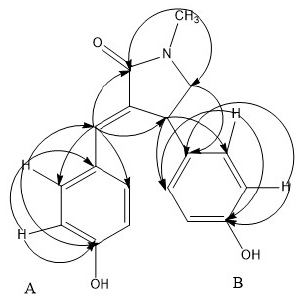
Figure 2. Key HMBC (H → C) correlations of the pyrrolidine alkaloid isolated from the ethanol extract of O. japonica root barks.